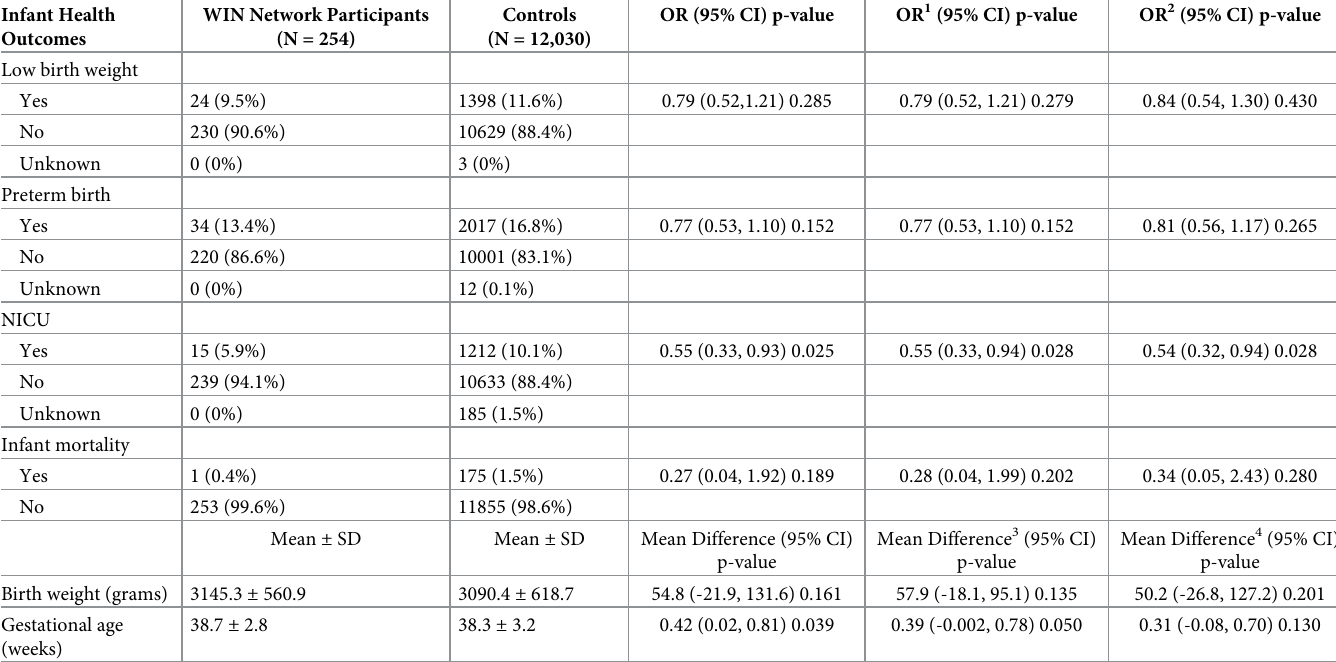
Table 2. Association between WIN Network participation and infant health outcomes.